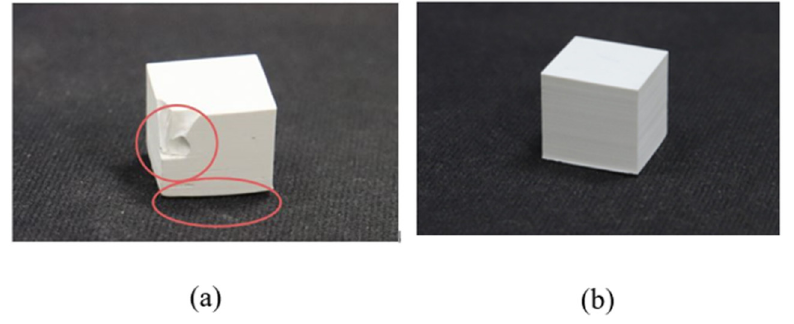
Figure 8. Curing depth curve for various exposure times (seconds).